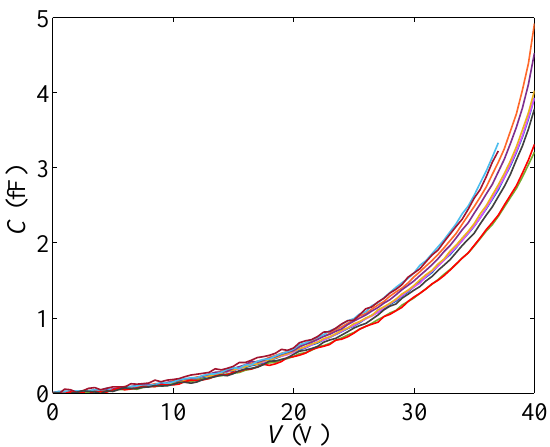
Figure 2. Experimentally measured capacitance change C vs. applied voltage V